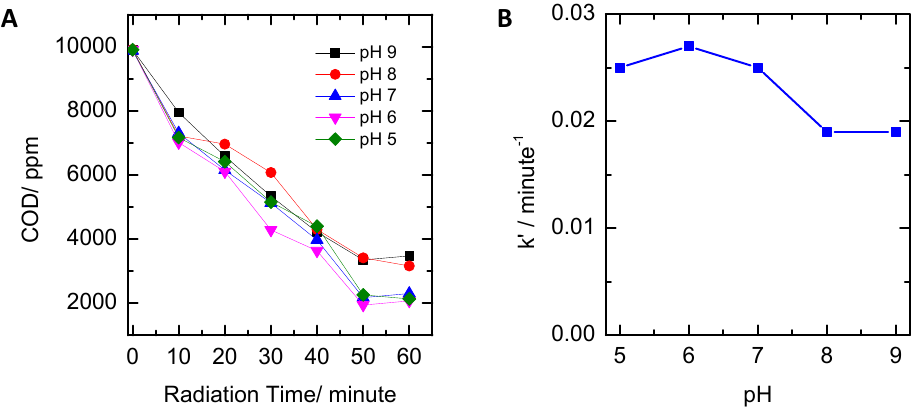
Figure 5. ( A ) Effects of pH in the degradation of COD and ( B ) reaction rate constant evaluated from experiment when varying pH of solutions.